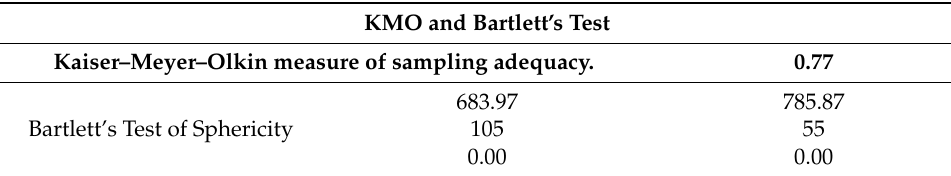
Table 4. KMO and Bartlett’s test result related to VM activities.